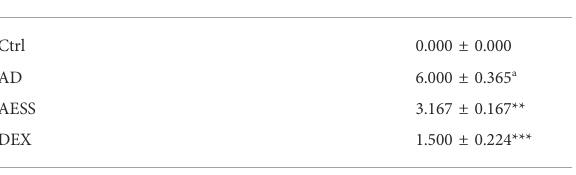
TABLE 4 Dermatitis score of mice.